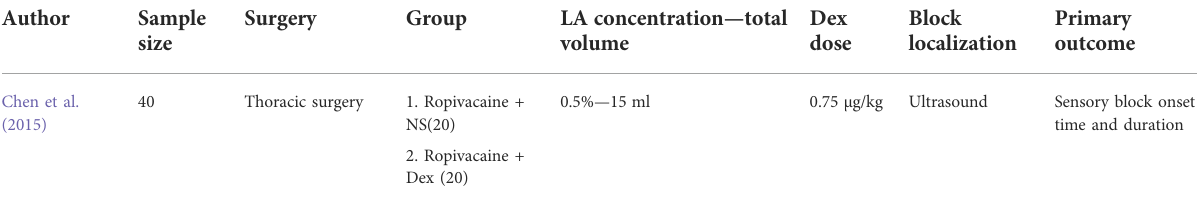
Table 2. It indicated that the LA type may be the source of heterogeneity of pain scores 24 h after surgery.